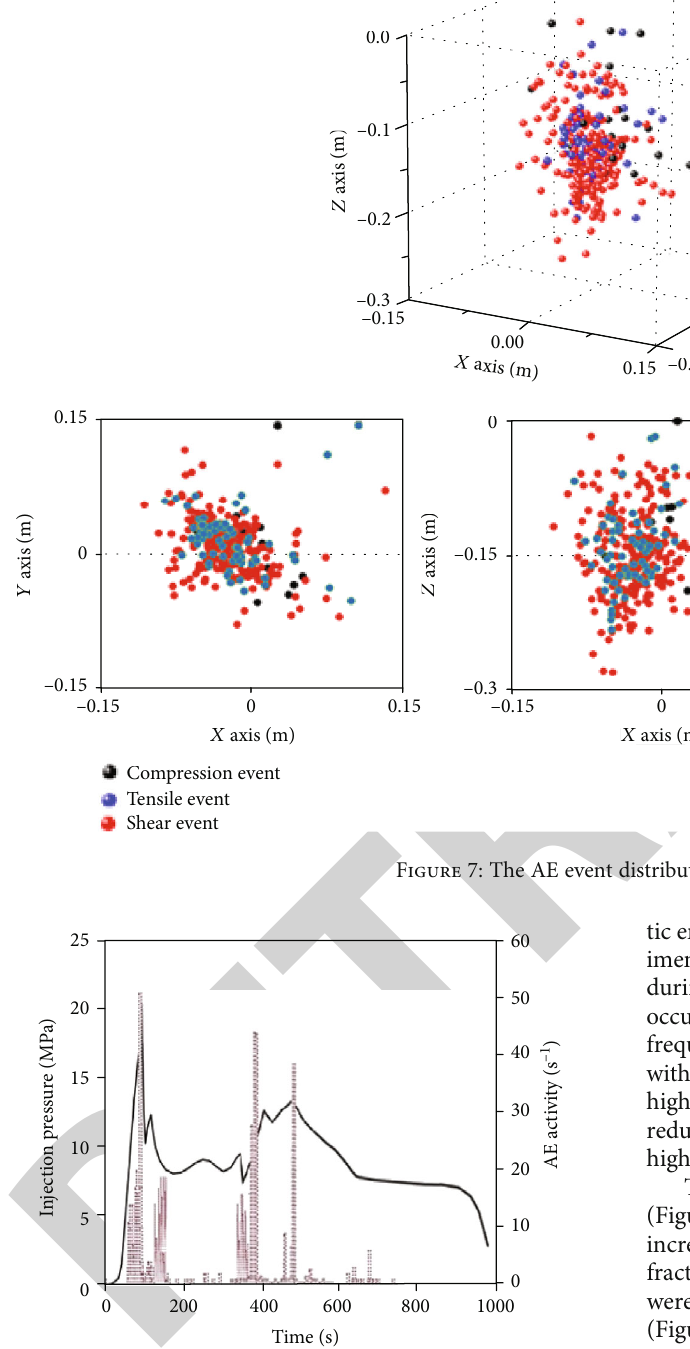
Figure 8: The injection pressure curve and AE activity of Sample